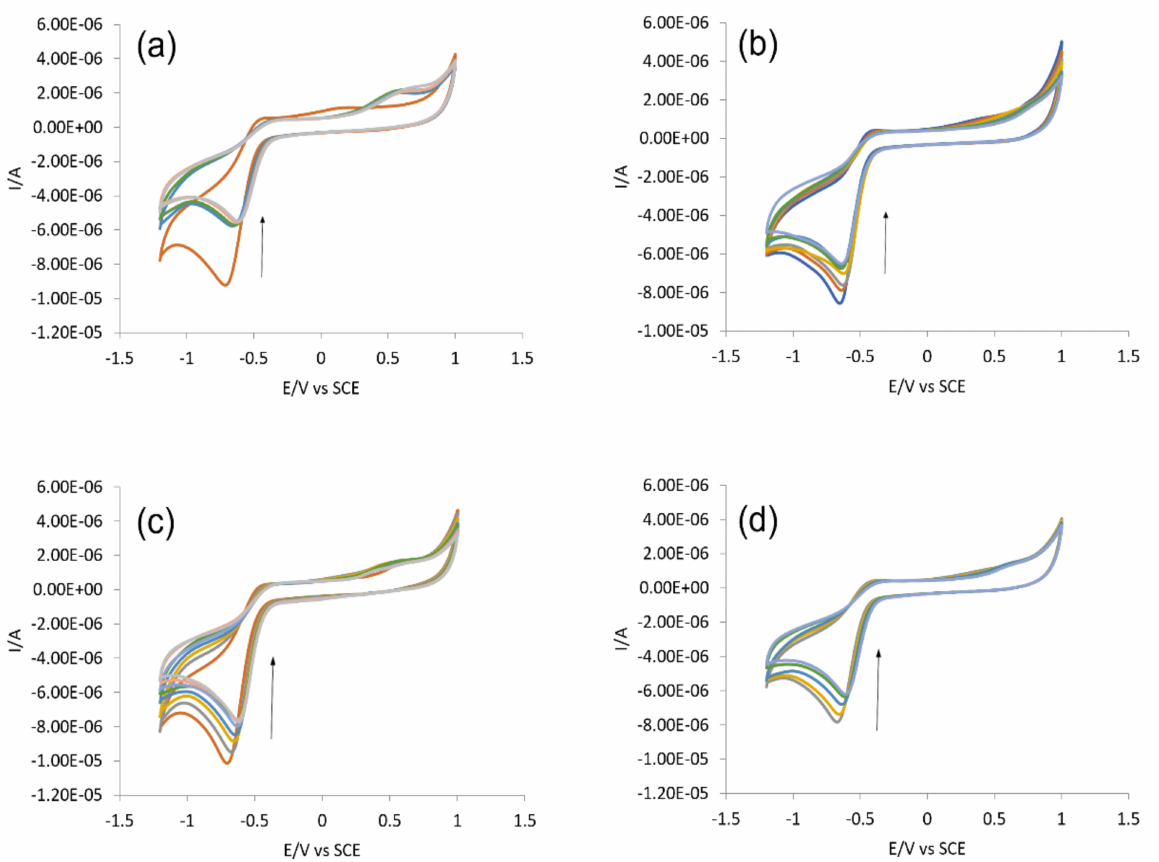
Figure 10. CV-responses of ( a ) IST-01, ( b ) IST-02, ( c ) IST-03, and ( d ) IST-04 before and after DNA titrations. Arrow direction indicates the drop in the peak current of tested